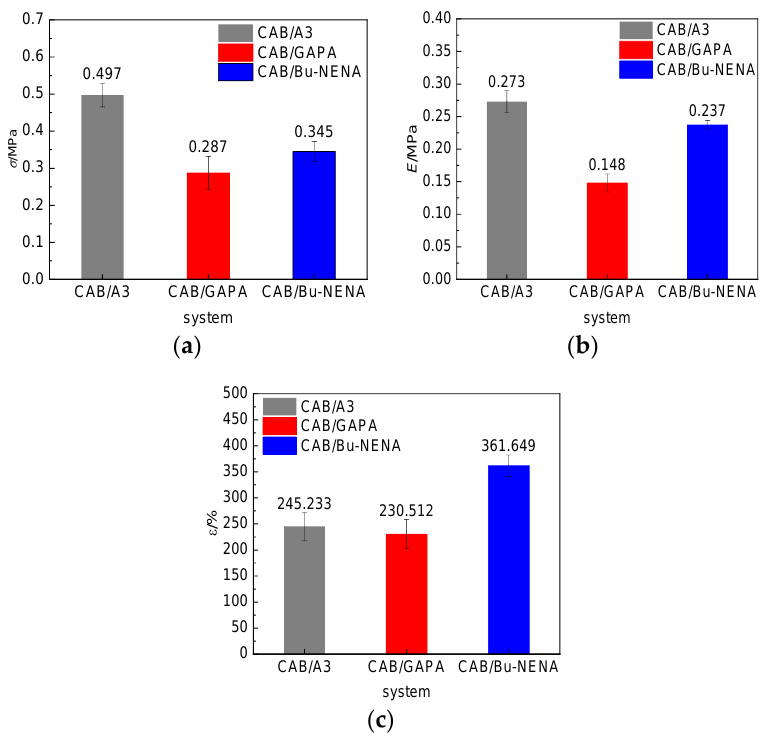
Figure 6. Mechanical properties of CAB/plasticizer systems measured experimentally: ( a ) Tensile strengths ( σ ), ( b ) Young’s moduli ( E ), and ( c ) strains at break ε .